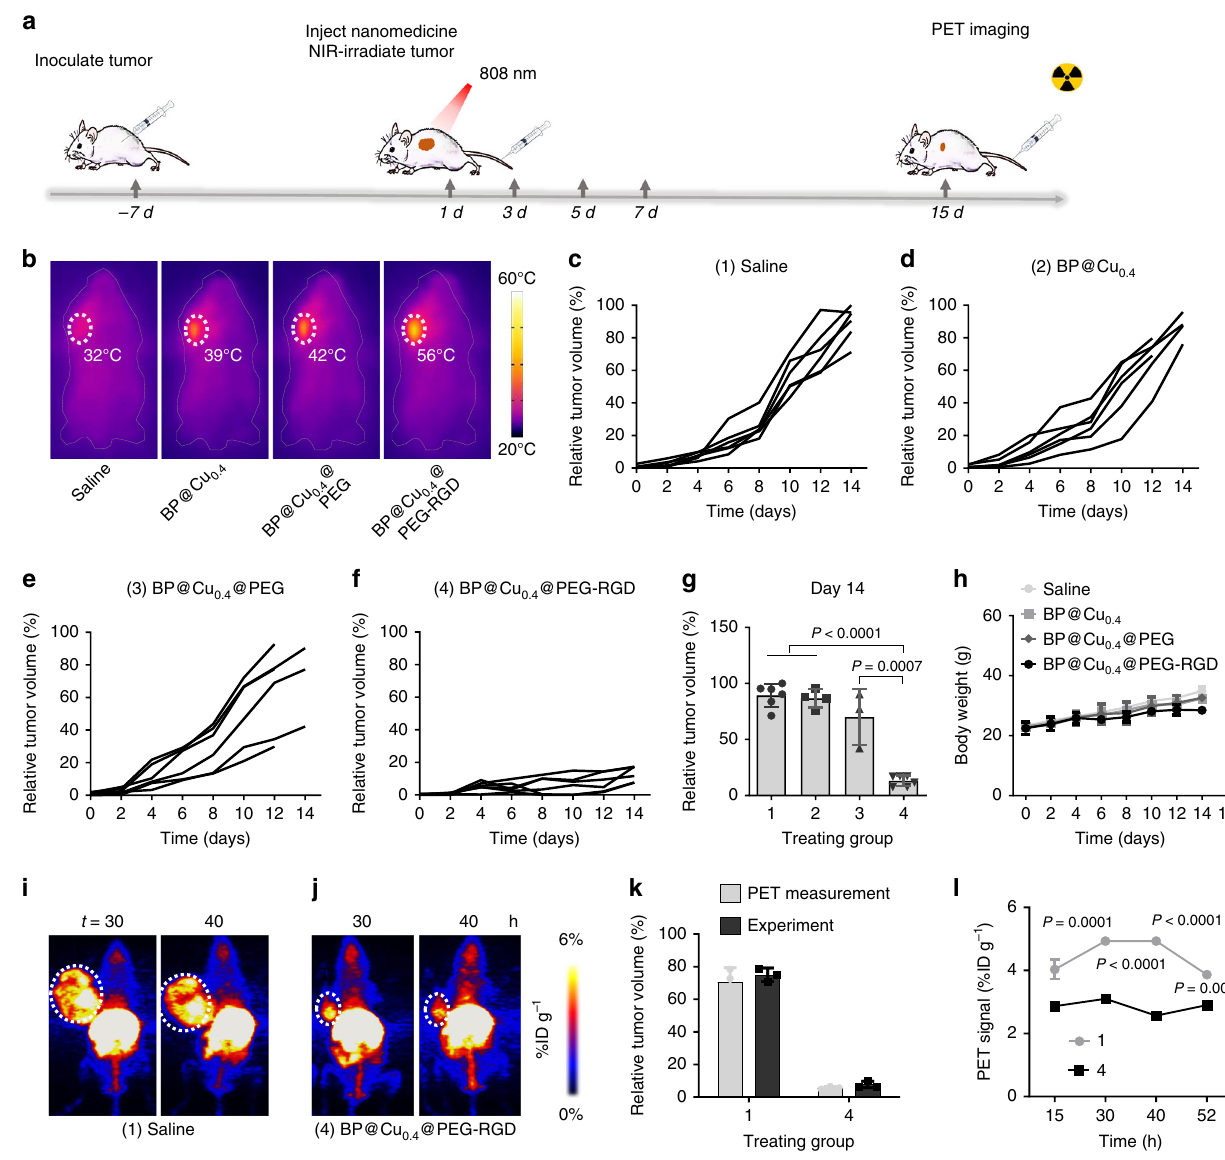
Fig. 7 In vivo tumor therapy. a Therapy approach for tumor-bearing mice. b Infrared thermal images of tumor-bearing mice injected with (1) saline, (2) BP@Cu 0.4 , (3) BP@Cu 0.4 @PEG, or (4) BP@Cu 0.4 @PEG-RGD under 808 nm laser irradiation (1.0 W cm − 2 ) for 2 min. The white circles denote the tumor sites. c – f B16F10 tumor growth curves for each mouse after different treatments: c saline, d BP@Cu 0.4 , e BP@Cu 0.4 @PEG, or f BP@Cu 0.4 @PEG-RGD. g Relative tumor volume after different treatments on day 14. mean ± s.d., n = 4 – 6 biologically independent mice. The number 1 – 4 was assigned different treatments indicated in ( c – f ). The same below. The statistical signi fi cance was assessed using unpaired two-tailed student ’ s t -test. h Body weight curves of B16F10 tumor-bearing mice after different treatments, mean ± s.d., n = 6. i , j MIP PET images of B16F10 tumor-bearing mice after 2 weeks of treatment with saline or BP@Cu 0.4 @PEG-RGD, respectively. PET images were taken at 30 and 40 h after intravenous injection of saline or BP@ 64 Cu@PEG-RGD. The white circles denote the tumor sites. k Comparison of tumor volumes from PET images and experimental measurements, mean ± s.d., n = 3 biologically independent mice. l Quanti fi cation of BP@ 64 Cu@PEG-RGD uptake in tumors at different time points. The PET signal intensities were analyzed based on PET images in ( i ) and ( j ). The data represents the mean ± s.d., n = 3 biologically independent mice. The error bars represent s.d. values. Analyzed by two- way ANOVA, followed by Bonferroni ’ s multiple comparisons signi fi cantly larger than those in mice treated with BP@Cu 0.4 @- PEG-RGD (Fig. 7j). From the 3D PET images, we measured the tumor size and compared them with the tumor volumes from experimental measurements. The data from different measure- ment methods matched each other perfectly, suggesting the feasibility of using PET imaging to plot tumor size and monitor tumor progression (Fig. 7k). Moreover, we used PET to measure the relative uptake of the nanodrugs in the tumor. The mice treated with BP@Cu 0.4 @PEG-RGD demonstrate smaller %ID g − 1